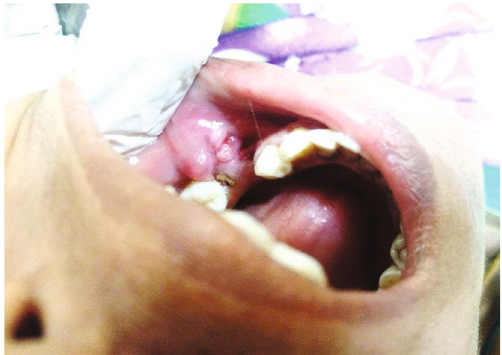
Figure 4: Clinical photograph showingnodular proliferous ulcerative growth measuring 3 × 2 centimetres on the alveolar mucosa.